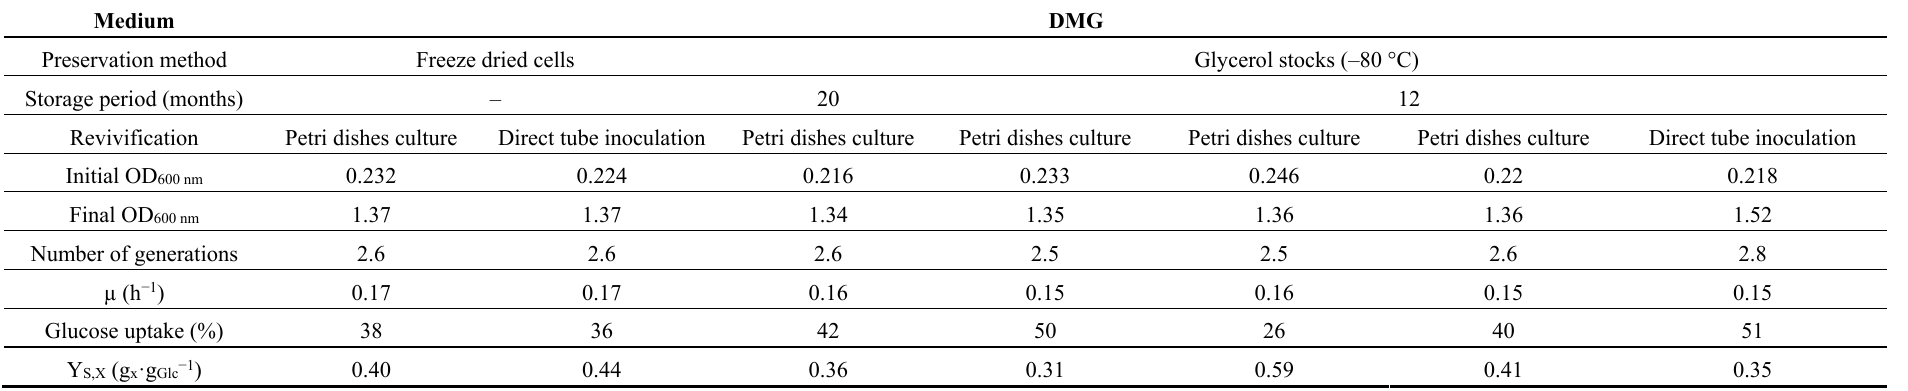
Table 4. Effect of the strain preservation methods, the frozen storage period, the type of strain revivification and the variability between colony forming unit on Petri dishes on the culture of Deinococcus geothermalis DSM-11302 in